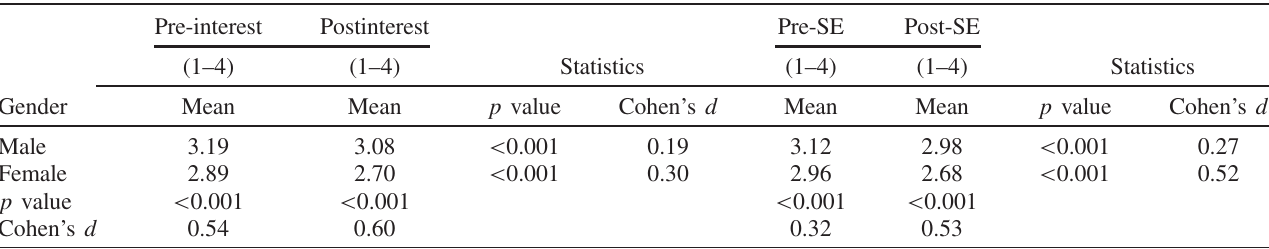
TABLE III. Descriptive statistics of pre- and post-self-efficacy and interest for female and male students.